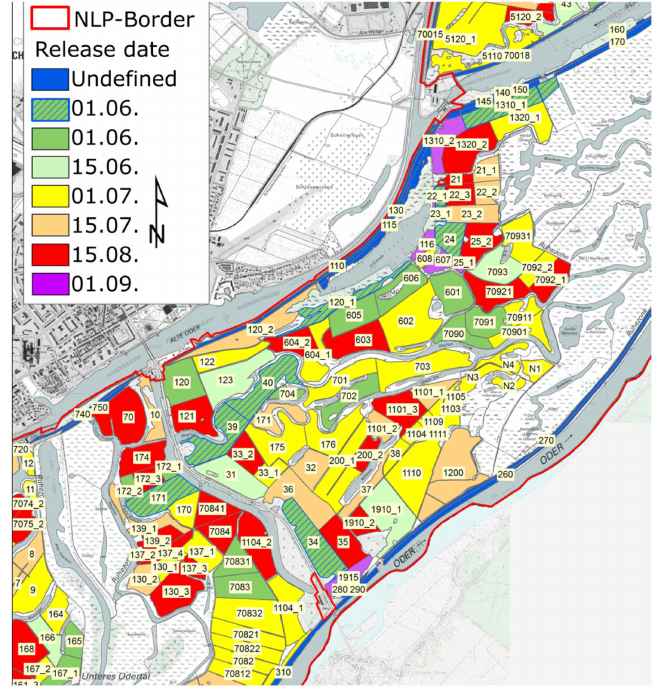
Figure 1. Dynamic grassland management in a section of the Lower Oder Valley National Park near the city of Schwedt (upper-left corner), displaying the release date for agricultural practices, including harvest, in the year 2021. The feedstock utilized in this study was sourced from areas harvested after August 15 (Source: Lower Oder Valley National Park administration). Table 1. Specifications of the presented experiments. Including the process type, the given code, the replications of performed experiments, the total amount of input material on a dry basis (db), the estimated highest heating temperature (HHT), as well as the estimated retention time. The code is composed of (1) lab- (L) and farm-scale (F); (2) via HTC (H), autothermal pyrolysis (A), or allothermal pyrolysis in an inert environment (I); (3) as batch (B) or continuous (C) process; and (4) from